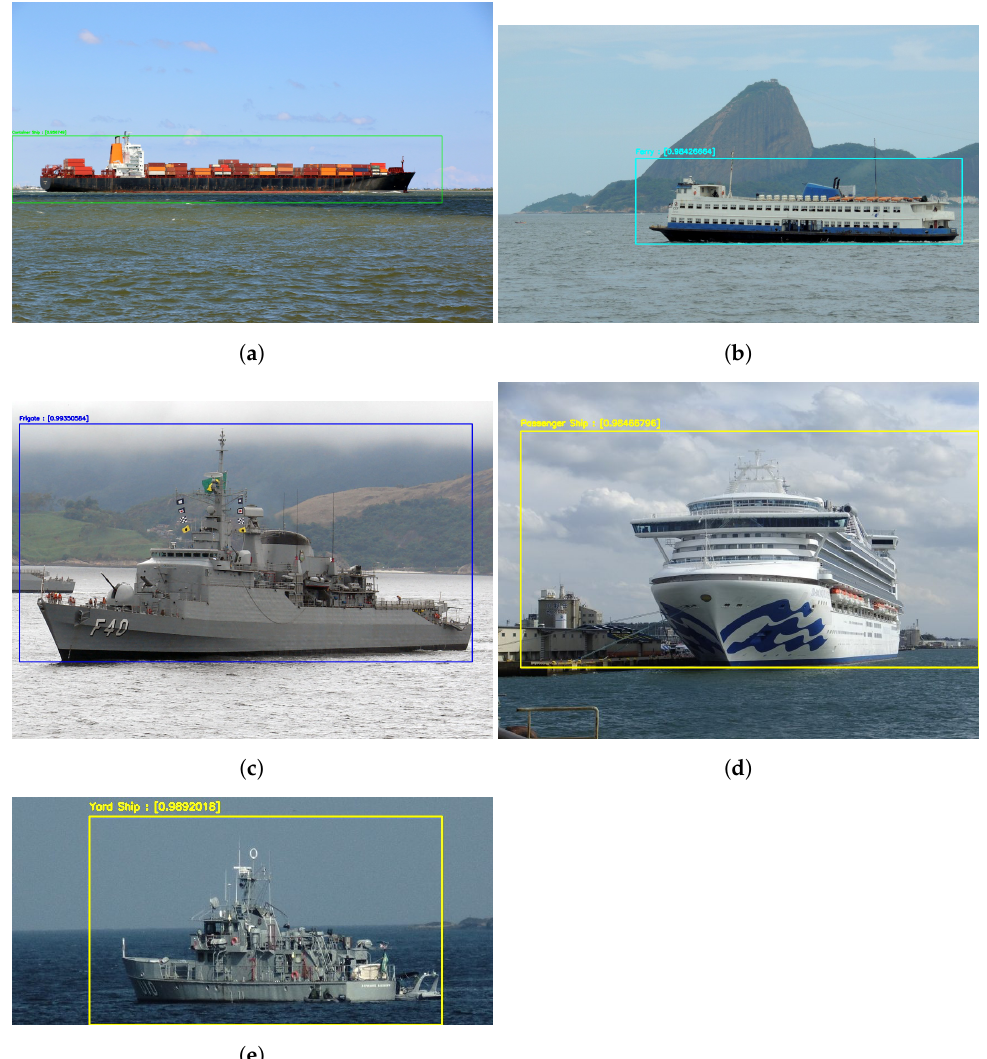
Figure 15. Results of the detection and classification model applied on real images from the Inter- net. The classification probabilities are: ( a ) Container Ship, 0.98; ( b ) Ferry, 0.98; ( c ) Frigate, 0.92; ( d ) Passenger Ship, 0.98; and ( e ) Yard Ship,